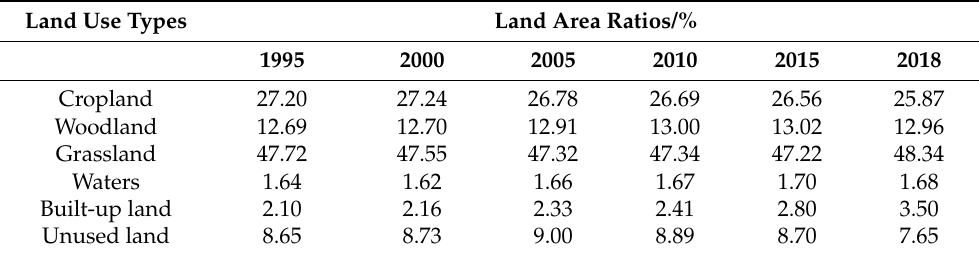
Table 8. Proportion of land use area in the Yellow River Basin from 1995 to